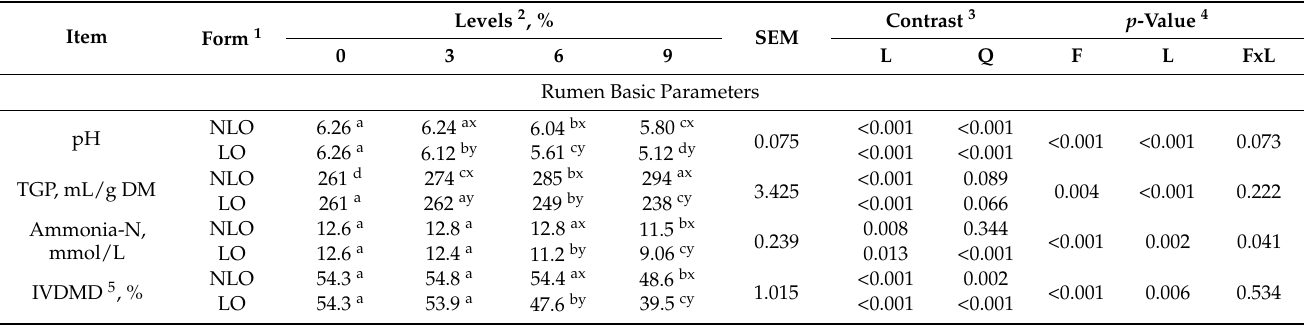
Table 6. Effect of the supplementation of raw and nanoemulsified linseed oil on basic rumen parameters, volatile fatty acid, and fatty acid